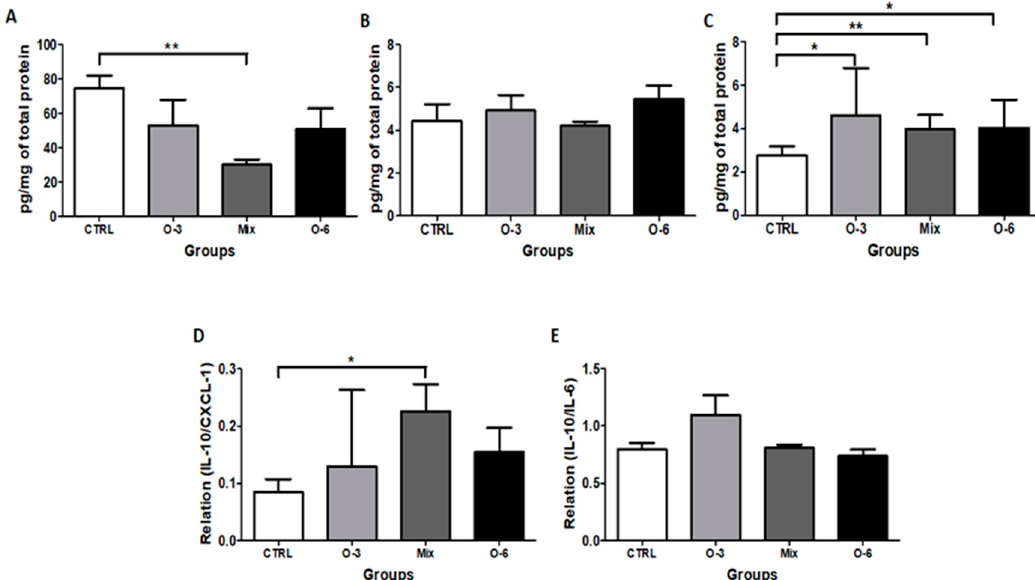
Figure 4. Determination of cytokines in vivo. C57BL/6 mice were coinjected with 10 6 B16F10 apoptotic cells plus a sub-tumorigenic dose of 10 3 B16F10 viable melanoma cells in a subcutaneous tissue. After the coinjection, the mice were treated by gavage during five consecutive days with fish oil rich in omega-3 or soybean oil rich in omega-6 or a mixture of these oils in a ratio of 1:1. After 21 days, the tumors were removed and a homogenate was obtained to evaluate the concentration of CXC ligand 1 (CXCL1) ( A ), interleukin 6 (IL-6) ( B ), IL-10 ( C ), the ratio between IL-10 and CXCL1 (IL-10 / CXCL1) ( D ) and the ratio between IL-10 and IL-6 (IL-10 / IL-6) ( E ) in the tumor microenvironment. All experiments were performed using groups of five 6–8 week old female mice in, at least, two independent experiments. The risk value α was set at 5% ( p < 0.05). * p < 0.05, ** p < 0.01.